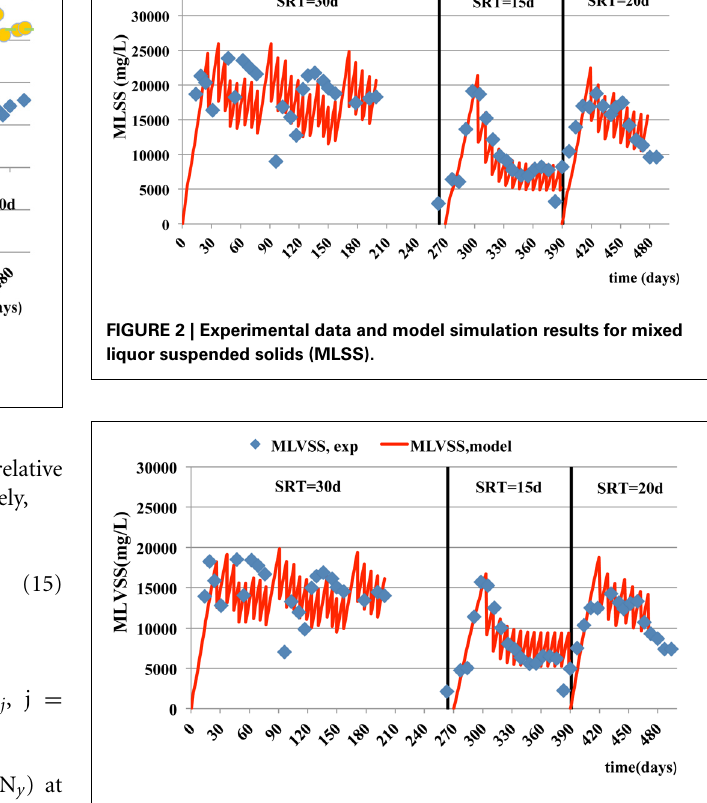
FIGURE 3 | Experimental data and model simulation results the total biomass concentration (MLVSS).